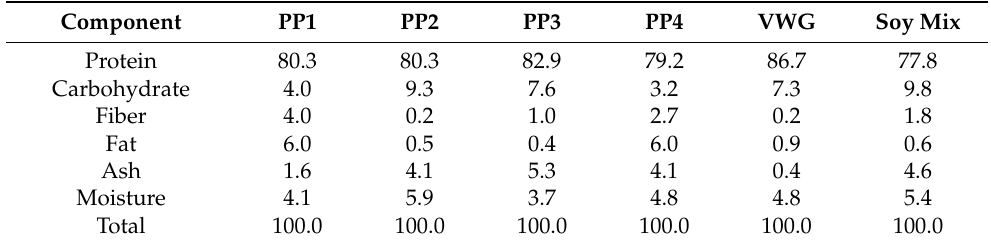
Table 2. Composition of extrusion treatments as determined by proximate analysis and supplier specifications